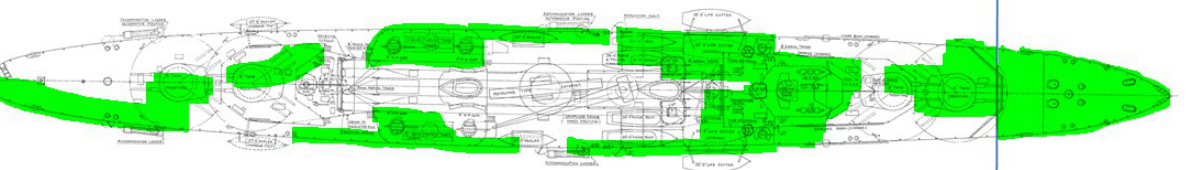
Figure 4. Schematic of HMAS Sydney (HMAS Sydney Search, 2010) with a green overlay showing area which can be partially reconstructed from the dataset